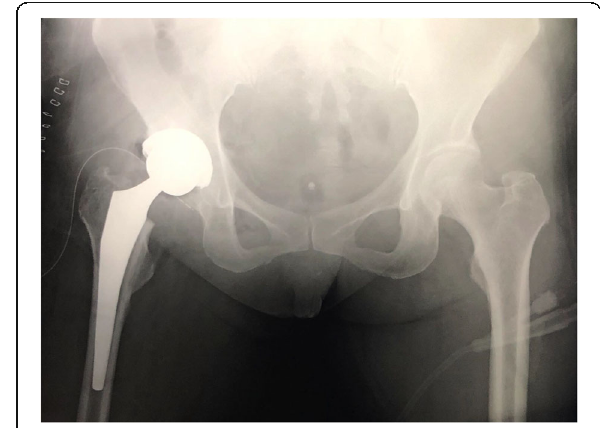
Fig. 1 Anteroposterior plain radiography of both hips after total hip arthroplasty